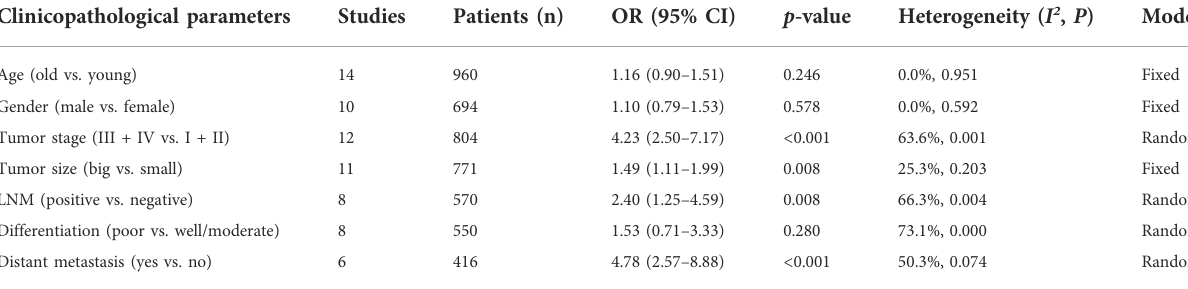
TABLE 3 Association of LINC00662 expression with clinicopathological features.